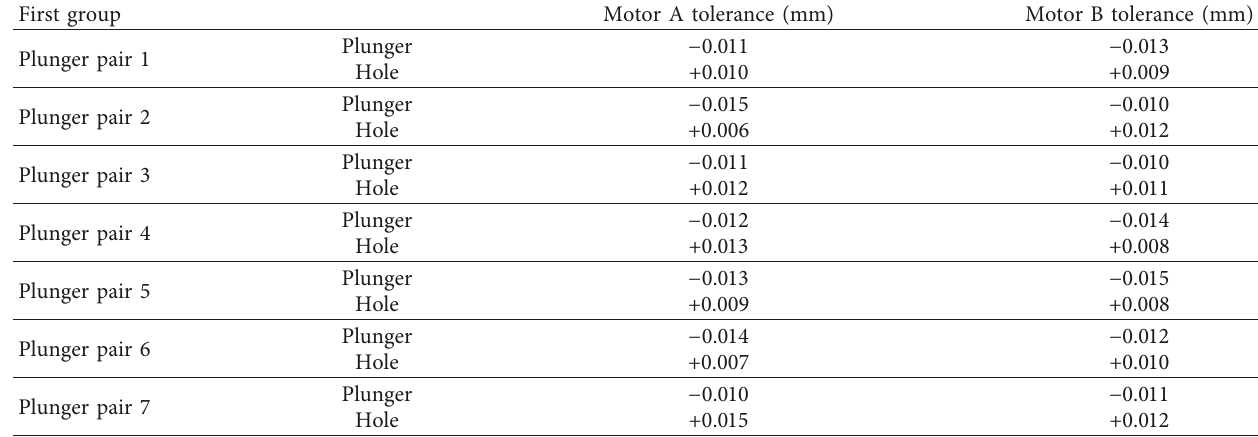
Table 4: The first group of dimensional tolerance table of the testing motor plunger pair.